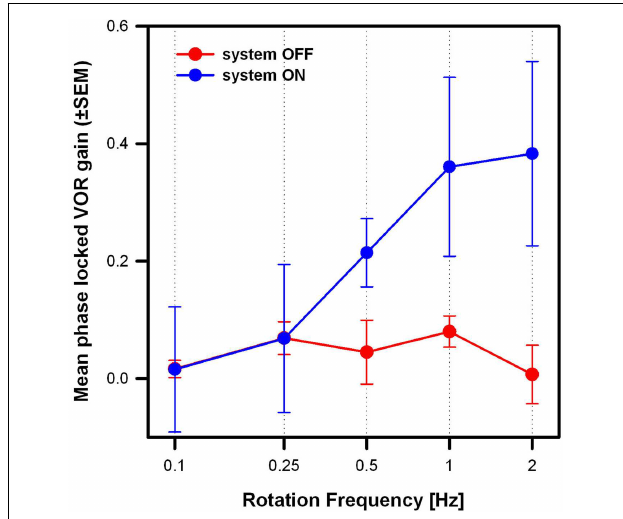
FIGURE 5 | Mean phase-lockedVOR gain ( ± SEM) versus rotation frequency of the three implanted patients .Two stimulation conditions are compared: system OFF (red plot) and system ON (blue plot; modulation strength corresponding to 50% of each patients dynamic range).